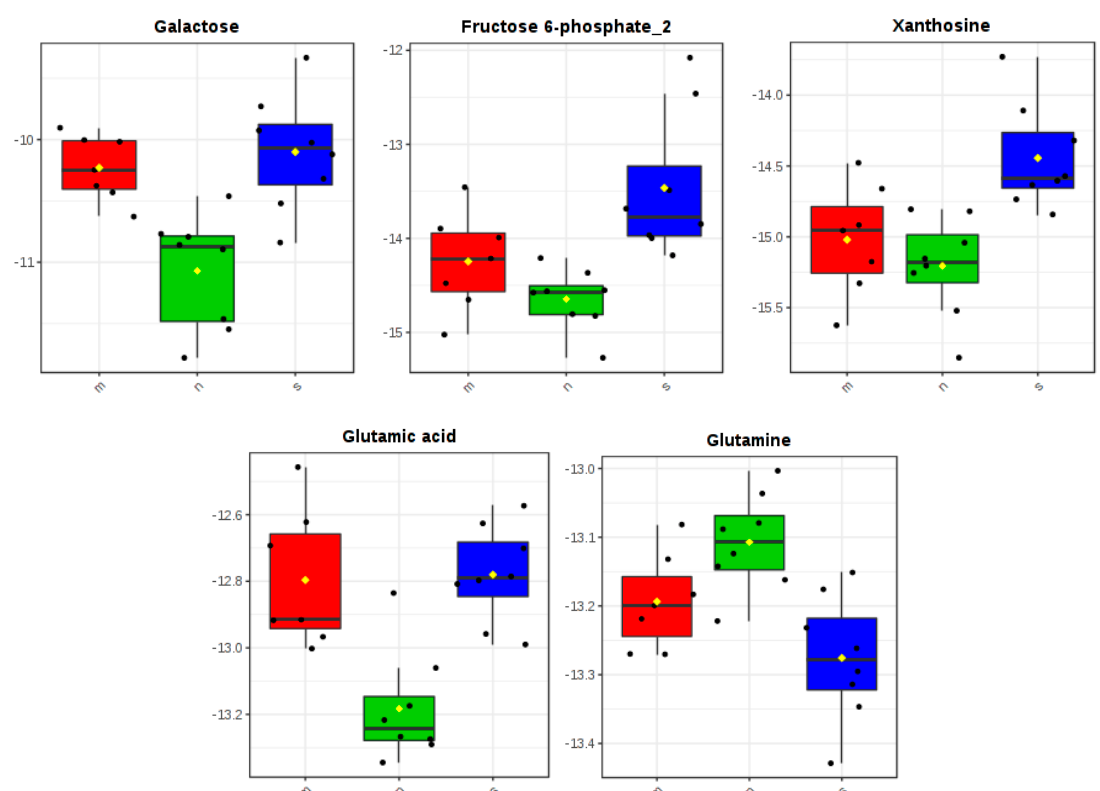
Figure 4. Metabolites that were found to be differentially accumulated across three experimental groups: rats on the standard diet (s), with the zinc nanoparticles supplementation (n) and with the zinc microparticles supplementation (m).